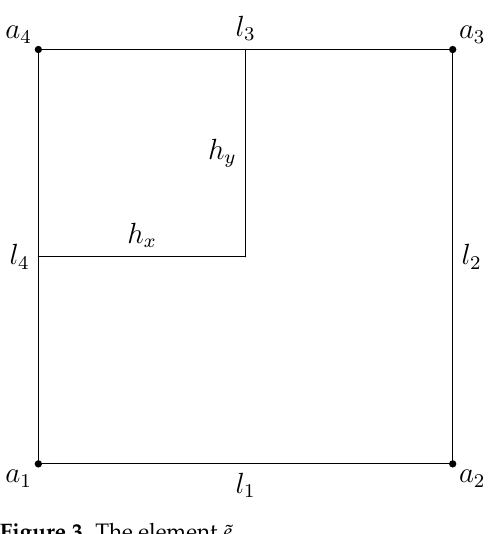
Figure 3. The element ˜ e